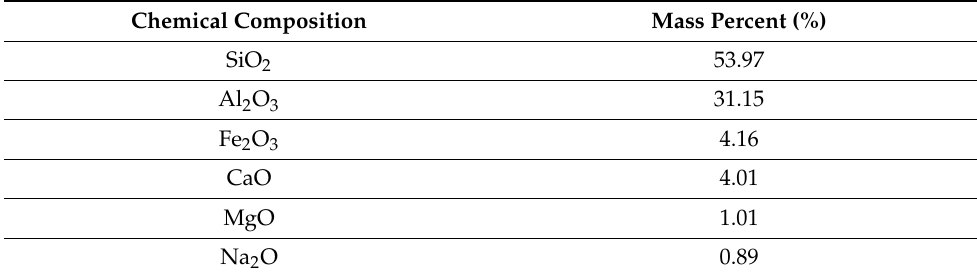
Table 4. Chemical composition of fly ash